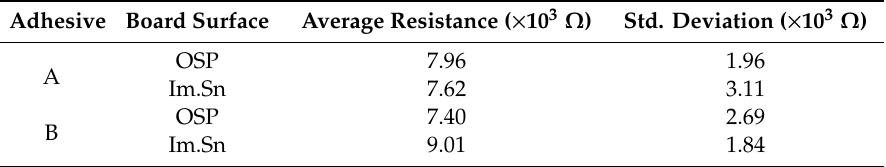
Table 2. Average resistance of adhesive joints and standard